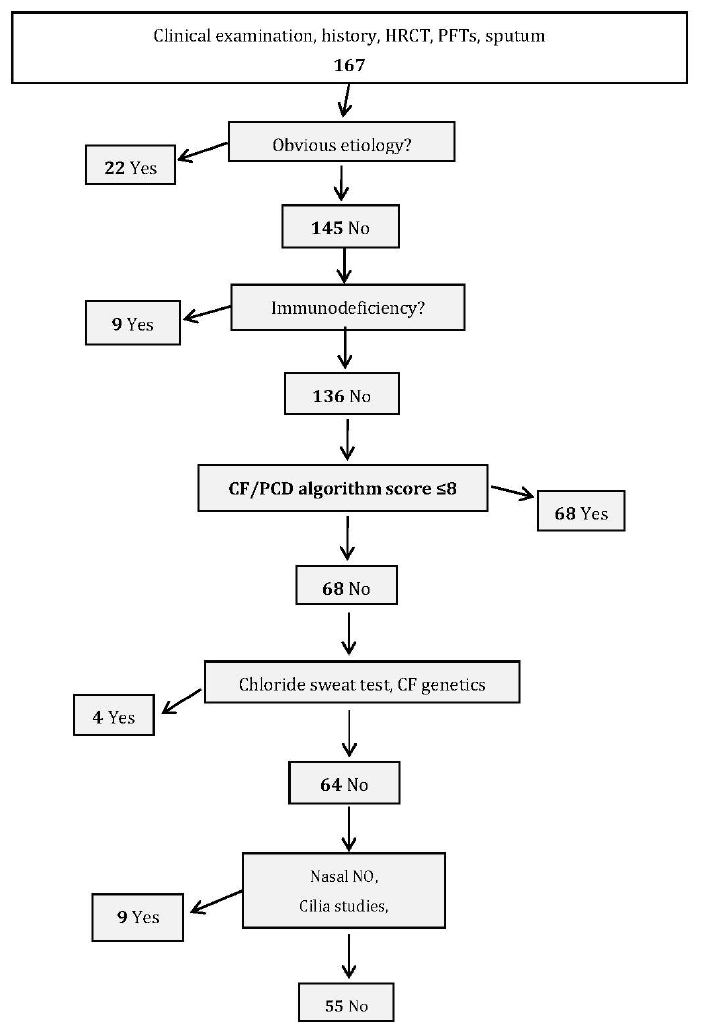
Figure 2. Proposed etiological work-up algorithm to diagnose CF or PCD. CF, cystic fibrosis; PCD, primary ciliary dyskinesia; HRCT, high-resolution computed-tomography scan; PFTs, lung function tests in the validation cohort .